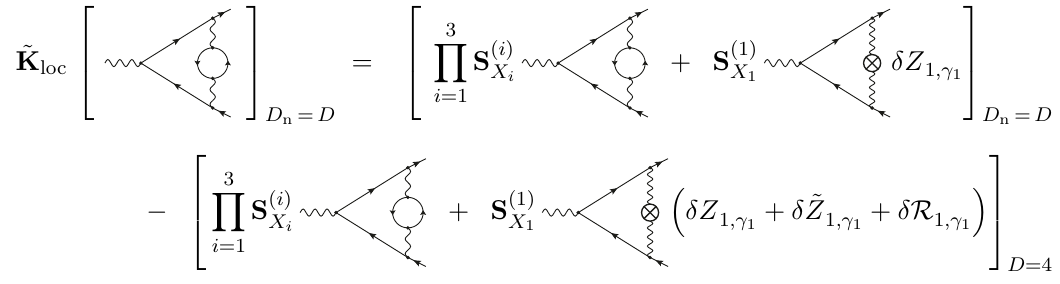
Figure 7 . Graphical representation of the master formula (5.60) for the derivation of two-loop rational counterterms for the case of a globally divergent two-loop diagram with a single divergent subdiagram (cid:13) 1 . The S ( i ) operators perform tadpole expansions along the corresponding chains X i